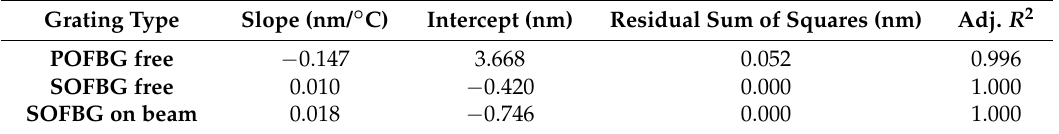
Table 5. The linear fitting results of thermal response of POFBG and